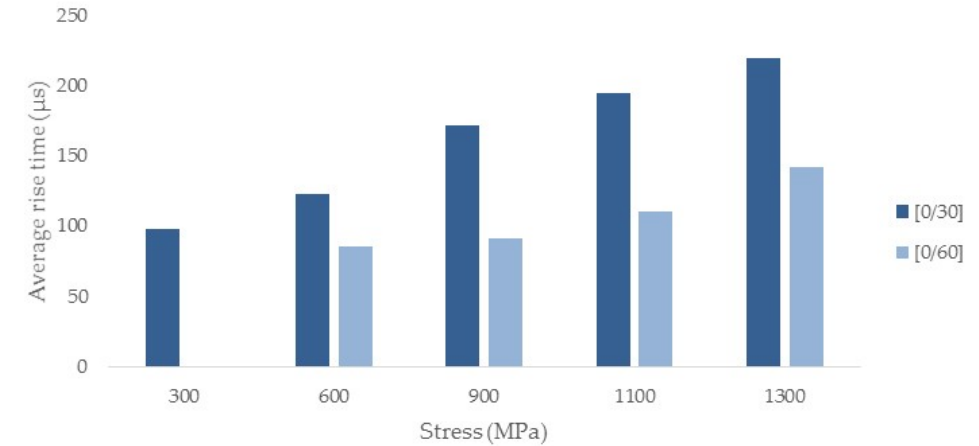
Figure 19. Evolution of average rise time values for the angle-ply laminates.